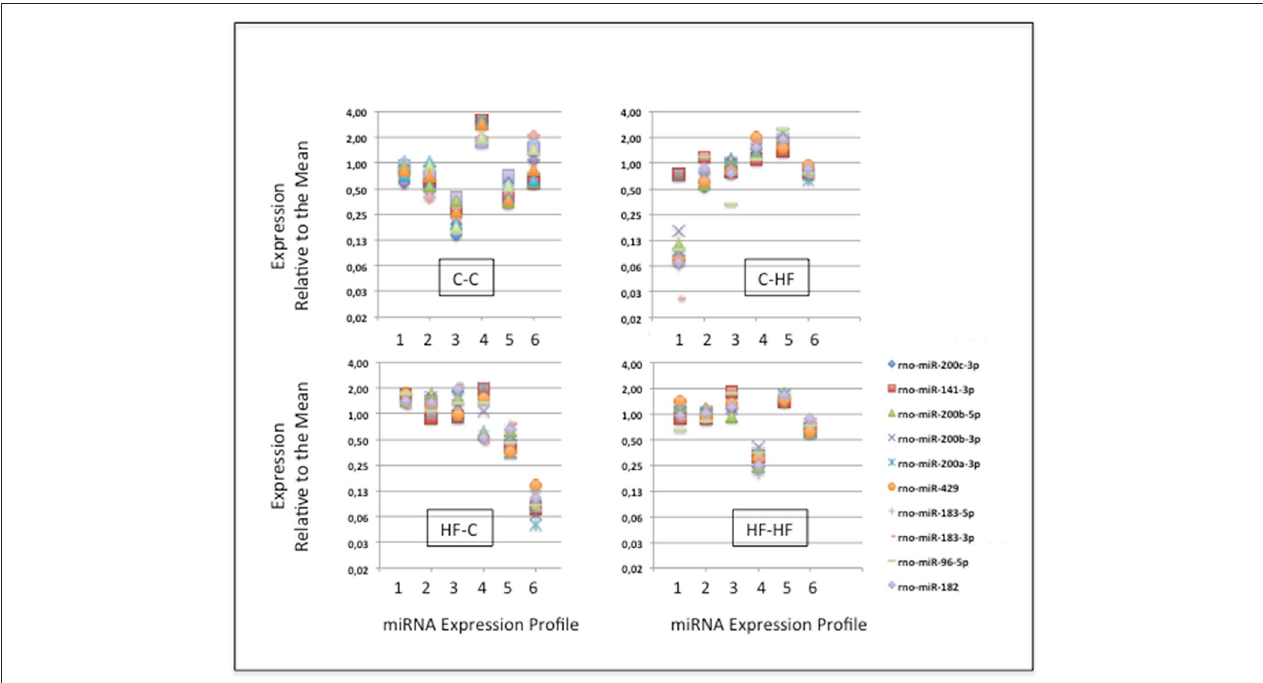
FIGURE 5 | The specific case of the miRNAs specified by clusters miR-96/182/183, miR-141/200c, and miR-200a/200b/429. Ten miRNAs are produced by clusters miR-96/182/183, miR-141/200c, and miR-200a/200b/429. In each group, in each of the six profiles, and for each miRNA, we calculated the expression relative to the mean by dividing individual miRNA read counts by the mean miRNA read count. The expression of the 10 miRNAs co-varies in each profile.